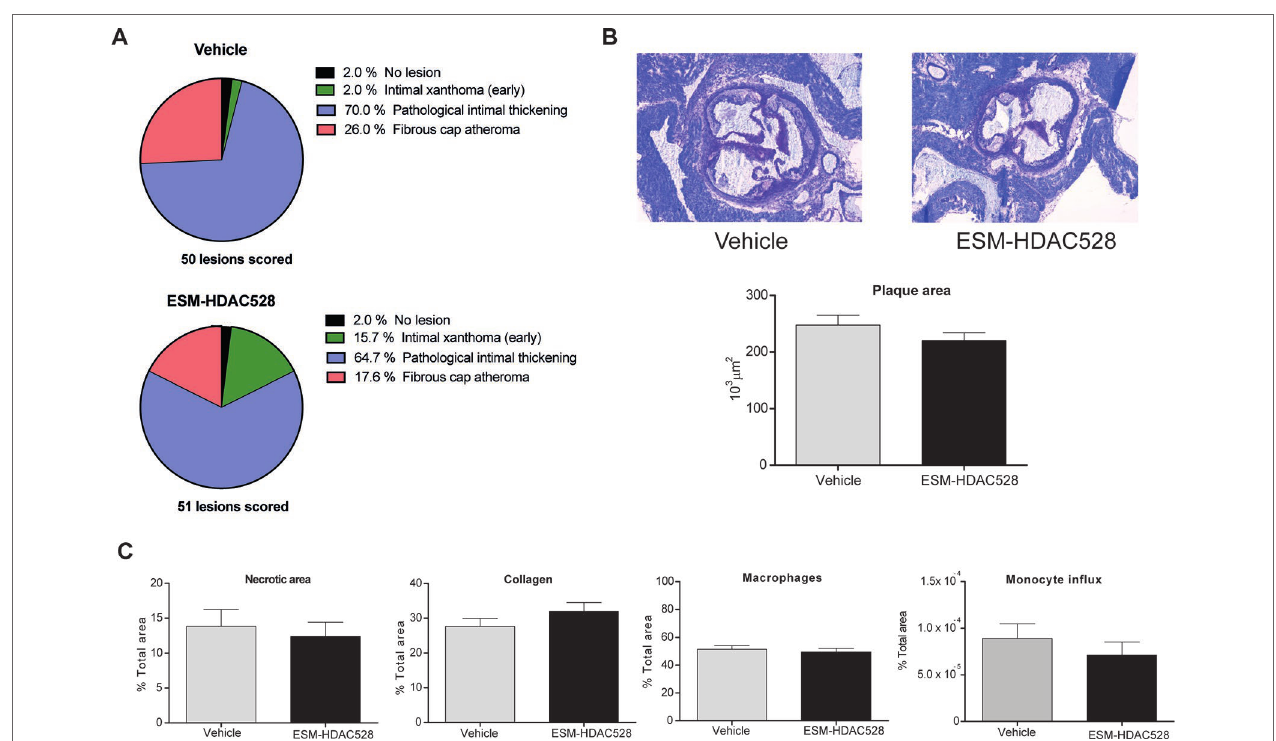
FIGURE 6 | ESM-HDAC528 does not reduce plaque formation. (A) Severity of the plaque for the different groups, the plaque is rated according to the morphology. n = 50 lesions in vehicle vs. n = 51 lesions in ESM-HDAC528. (B) Plaque size for the different groups. Representative images of the plaque area and measurement of plaque area for the different groups. n = 19 vehicle vs. n = 17 ESM-HDAC528. (C) Different disease characteristics: necrotic area, percentage of macrophages, collagen, and monocyte influx in the plaques of the different treatment groups. n = 19 vehicle vs. n = 17 ESM-HDAC528. Statistical significance was determined by unpaired t -test (B and C) or Chi-square test (A) (p < 0.05). All error bars represent the SEM